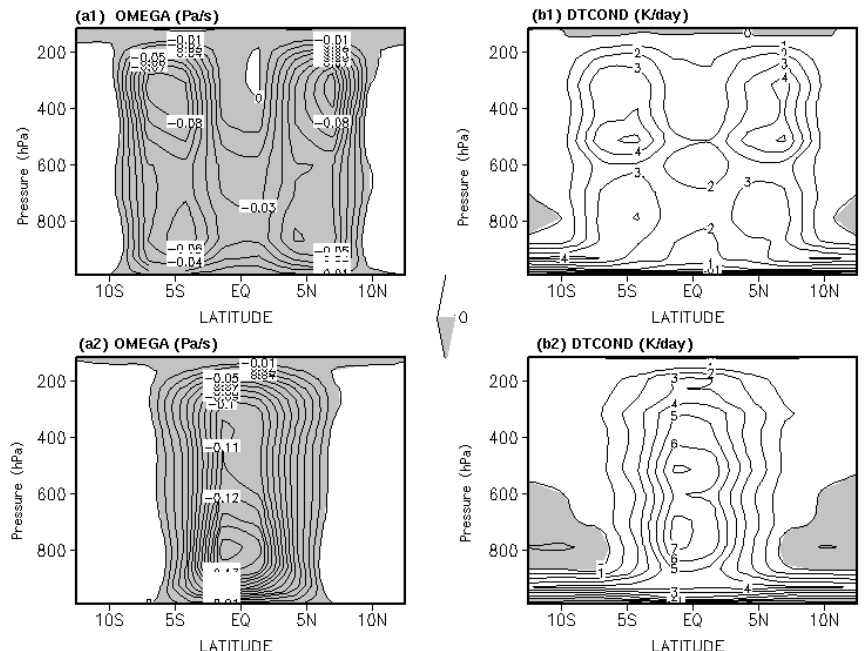
Fig. 13. Zonally averaged time mean quantities with TAU (1h) and TAU (8h). (a1) Pressure vertical velocity with TAU (1h), (a2) pressure vertical velocity with TAU (8h). (b1) Heating rate due to all the moist processes with TAU (1h), and (b2) heating rate due to all the moist processes with TAU (8h). Gray shading indicates the negative values. Negative omega means ascending motion, and negative heating rate means cooling due to evaporation of precipitating precipitation and melting of the precipitating ice. Contours are labeled inside the